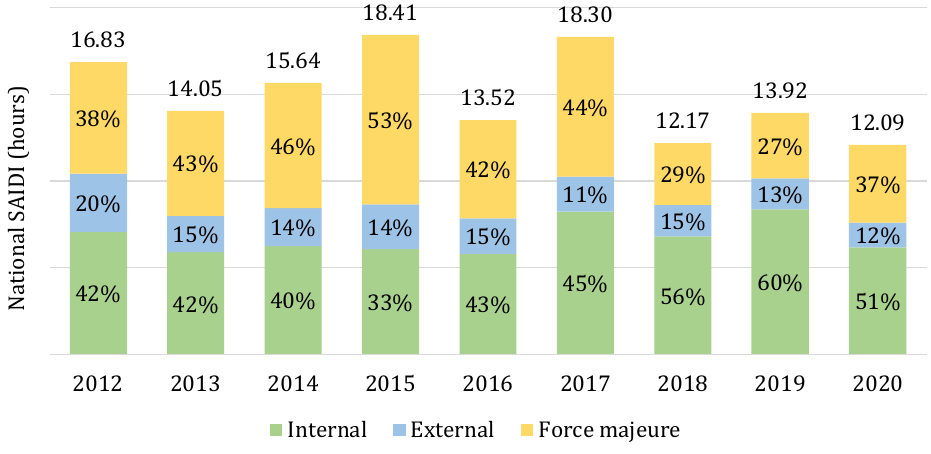
Figure 2. Duration of interruptions in hours in